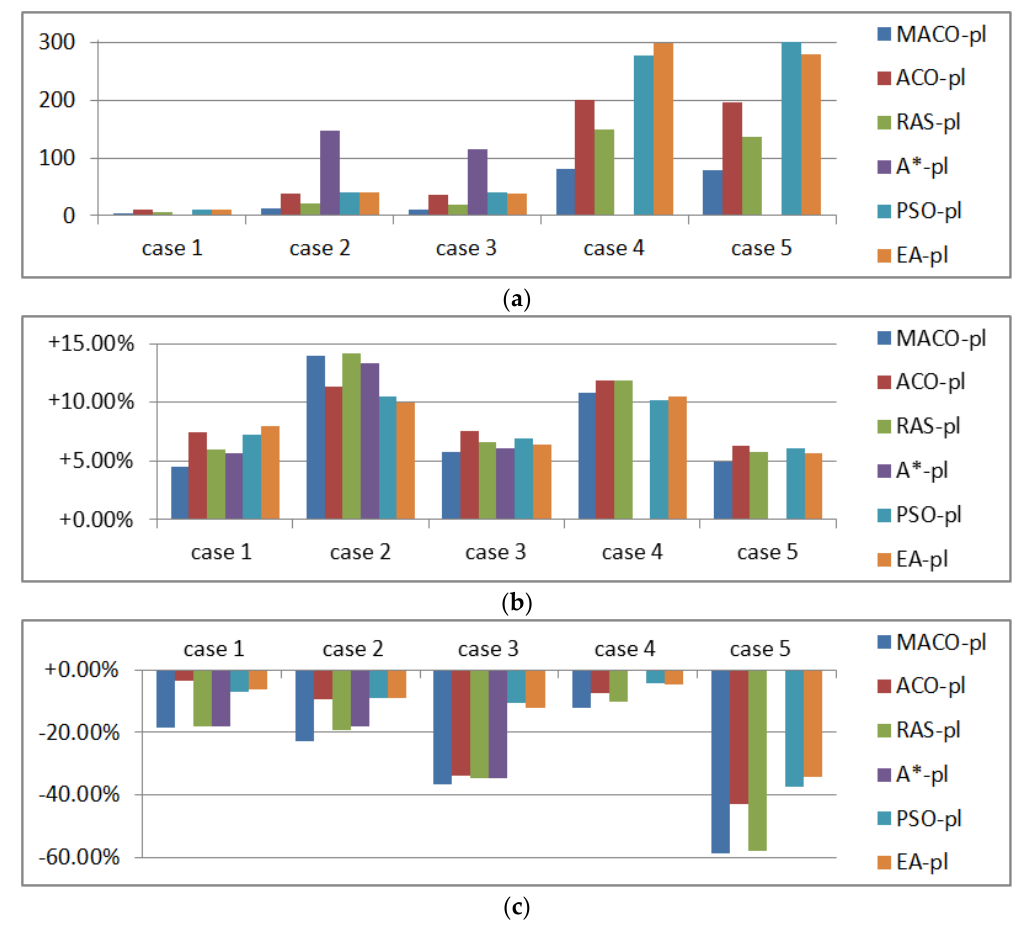
Figure 21. Planning results of 1–5 coordinate groups. ( a ) Processing time (s); ( b ) Comparison with L min ; ( c ) Comparison with H avT